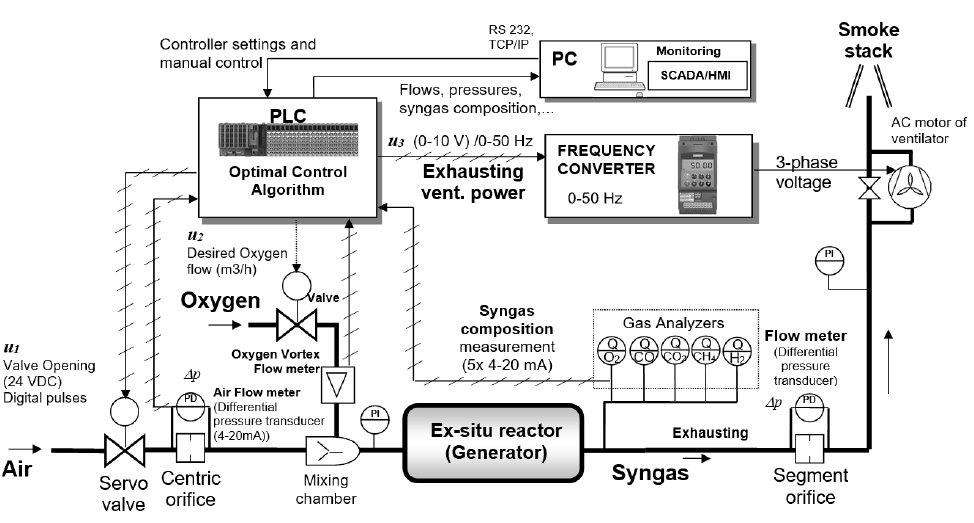
Figure 14. Connection scheme of ESC